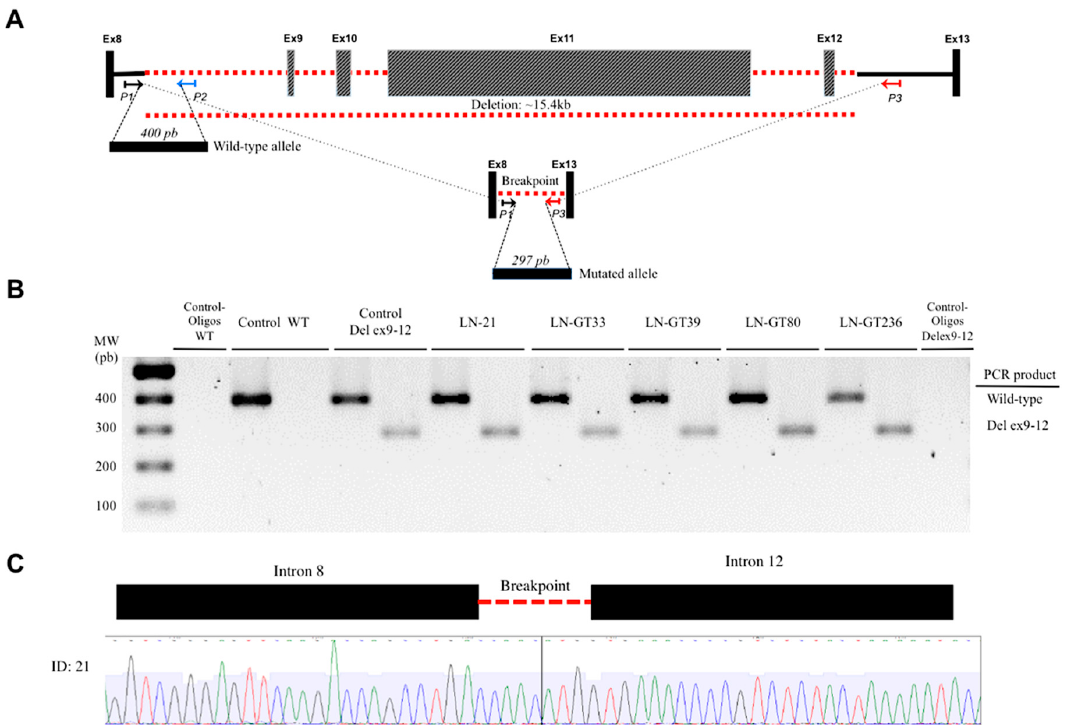
Figure 3. Detection of BRCA1 deletion of exons 9-12. ( A ) The locus of exons BRCA1 8 to 13 is indicated. Exons (not to scale) are depicted as boxes and introns as lines, where the discontinuous red line indicates the deleted exons 9-12. The location and orientation of the primers used for amplification of the wild-type (P1, P2) and the mutant alleles (P1, P3) are shown. The PCR products for both amplicons are depicted as horizontal boxes, with their respective number of bp. ( B ) The resolved PCR products of the patients with the deletion are shown, along with the wild-type and negative controls. ( C ) The electropherogram of the sequence shows the intron-intron junction in the deletion.